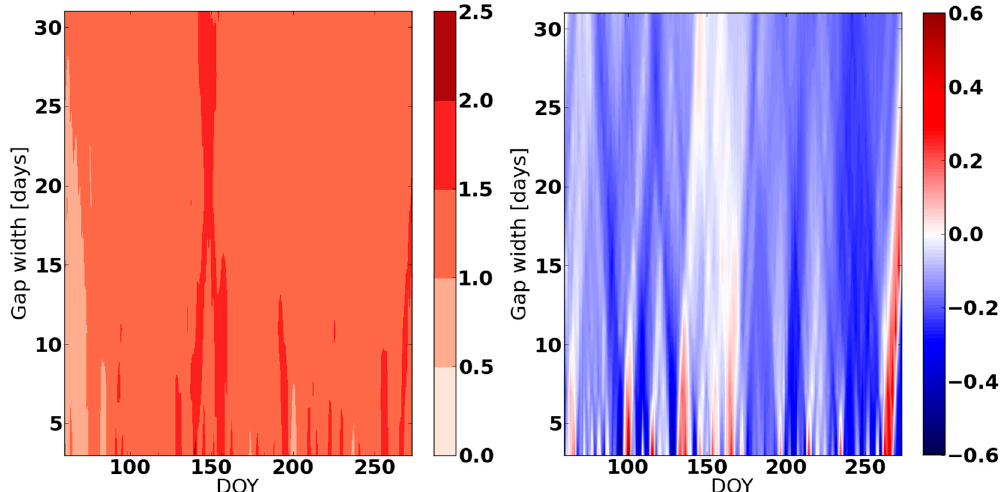
Figure 7. RMSE DEB ( left panel ) and (RMSE DEB -RMSE ERA5 ) difference ( right panel ) for DOY 60–273 in 2014 in Kikinda (Serbia).